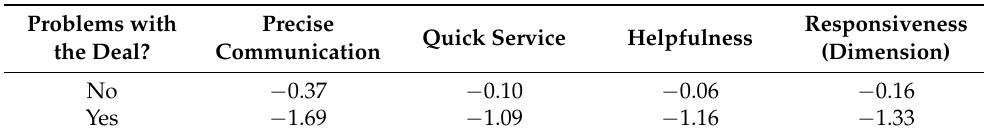
Table 8. Average service quality score for groups with and without problems during the timber deal. Differences between groups are significant on all items ( p < 0.01).